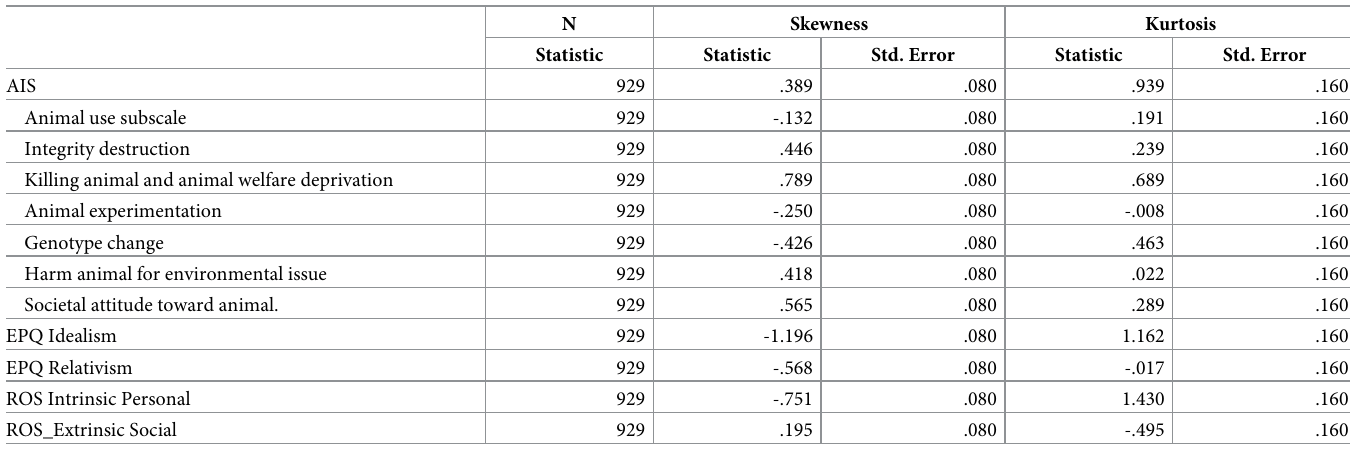
Table 4. Skewness and kurtosis value of main variables.